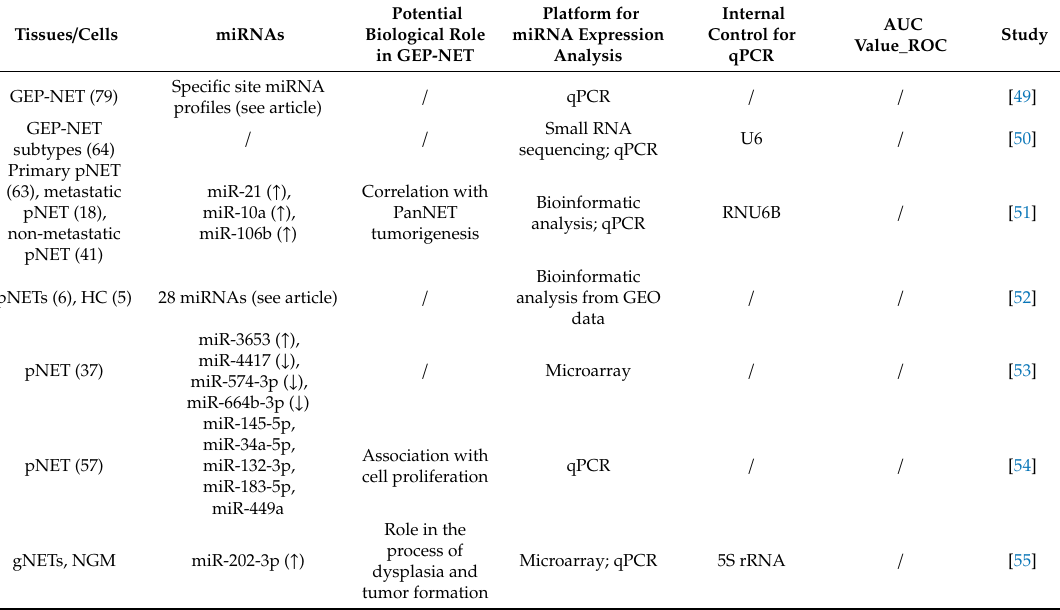
Table 2. Overview of di ff erentially expressed miRNA in gastro-entero-pancreatic neuroendocrine tumors